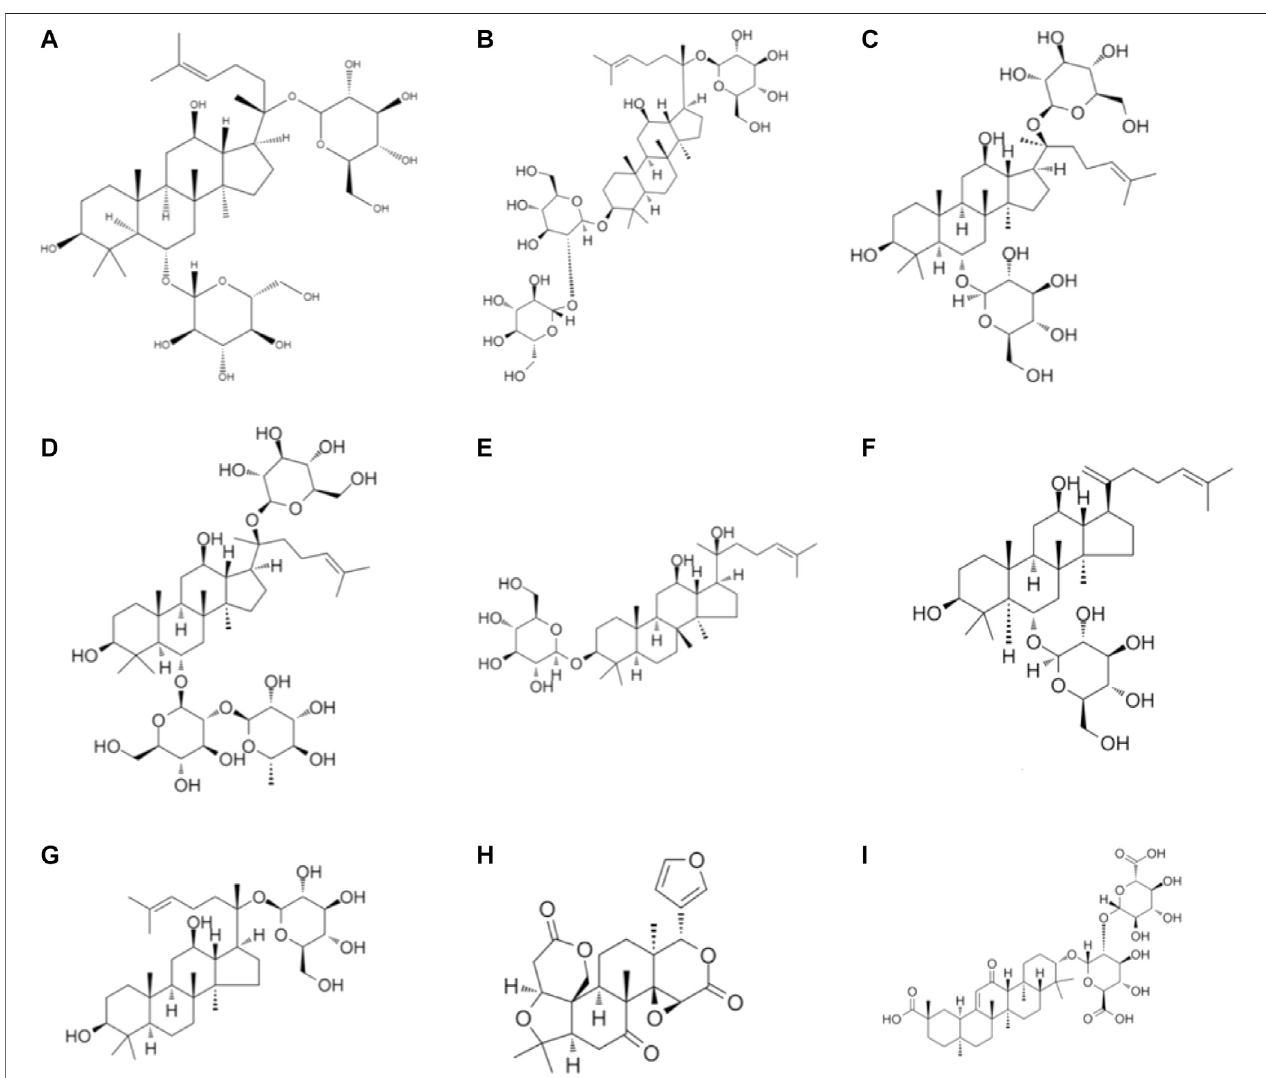
FIGURE3| Chemicalstructuresofterpenoid phytochemicals: (A) Ginsenoside (B) GinsenosideRd (C) GinsenosideRg1 (D) GinsenosideRe (E) GinsenosideRh2 (F) Ginsenoside RK3 (G) Ginsenoside metabolite compound K (H) Limonin (I) Glycyrrhizin acid.